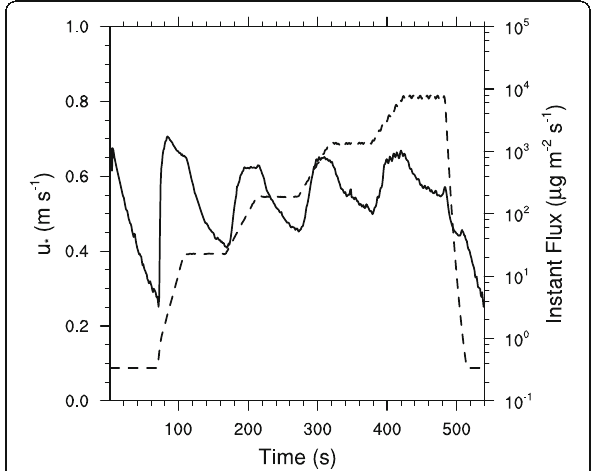
Fig. 5 PI-SWERL test response curve showing PM 10 supply limitations. The dashed line represents the friction velocity (u*) and the solid line is the instantaneous vertical flux of PM 10 . This test was from an area that is ephemerally flooded (L)